Question: What style of plot is this figure drawn as?
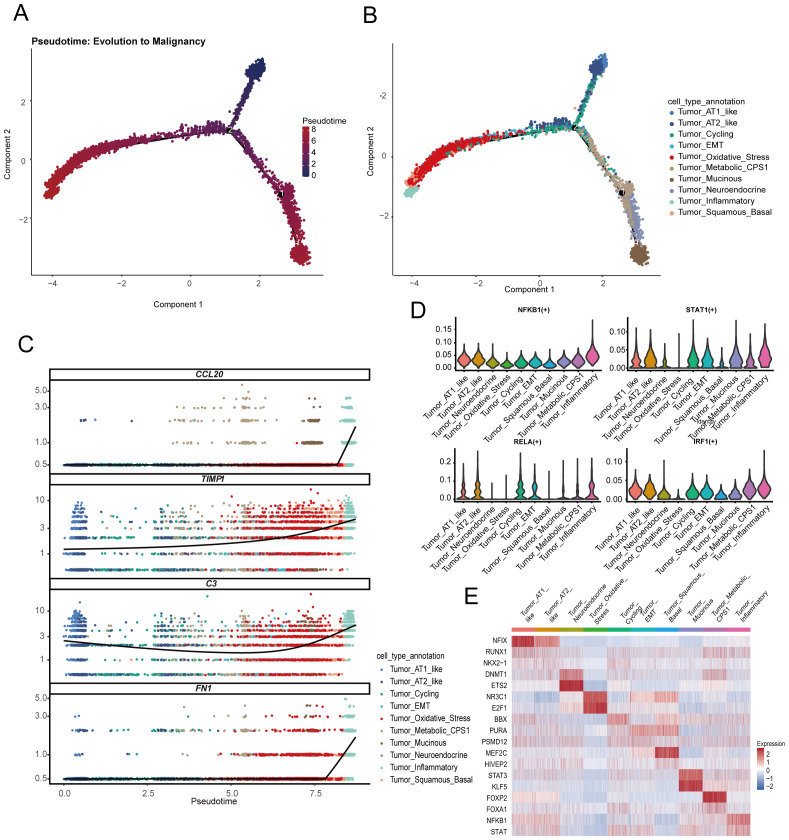
Answer: heatmap